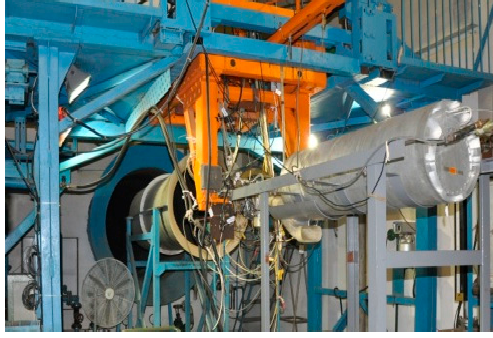
Figure 19. Compressor test facility.